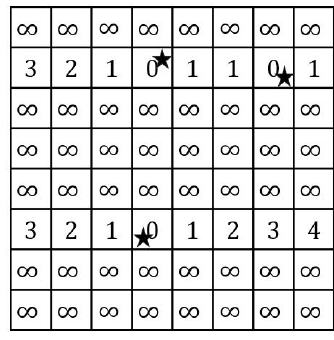
Figure 6. An Example of Step